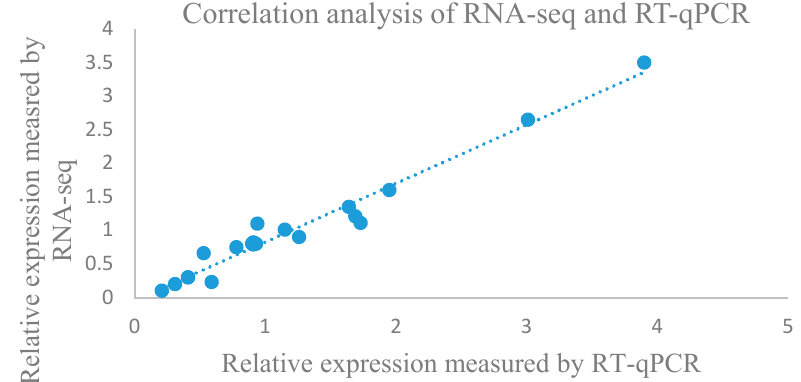
Figure 5. Confirmation of the expression patterns of lncRNAs using real-time quantitative polymerase chain reaction (RT-qPCR). Ten lncRNAs were randomly selected from differentially expressed lncRNA on different time point of drought stress. The x -axis indicates the relative expression measured by RT-qPCR. The Y -axis indicates relative expression measured by RNA sequencing (RNA-seq). The Pearson correlation of relative expression measured by RNA-seq and RT-qPCR was 0.91; ubiquitin ( UBQ ) was used as the reference gene.